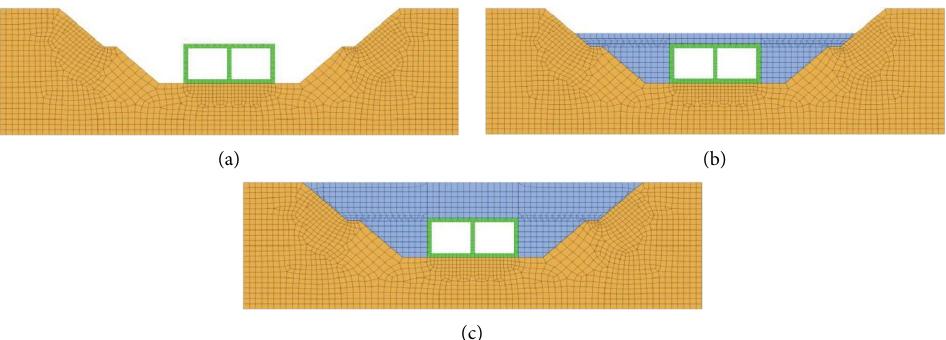
Figure 2: Backfll process. (a) Before backflling of the integrated pipe corridor. (b) After backflling of the integrated pipe corridor. (c) After backflling of the integrated pipe corridor pit.